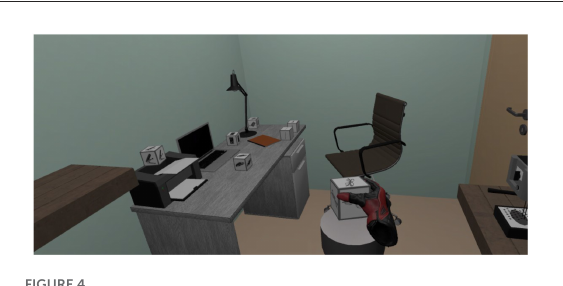
FIGURE4 An example of a VR scene from the participant’s perspective. The cubic grayscale objects are the distractors and the target object. In the lower central part of the image, a part of the end location is shown, which was represented by a column in the center of the room. The controller was represented by a virtual SteamVR glove. Note, that a grasping pose for each object was designed and generated and shown to the participant upon grasping a virtual object. For more details, see the main